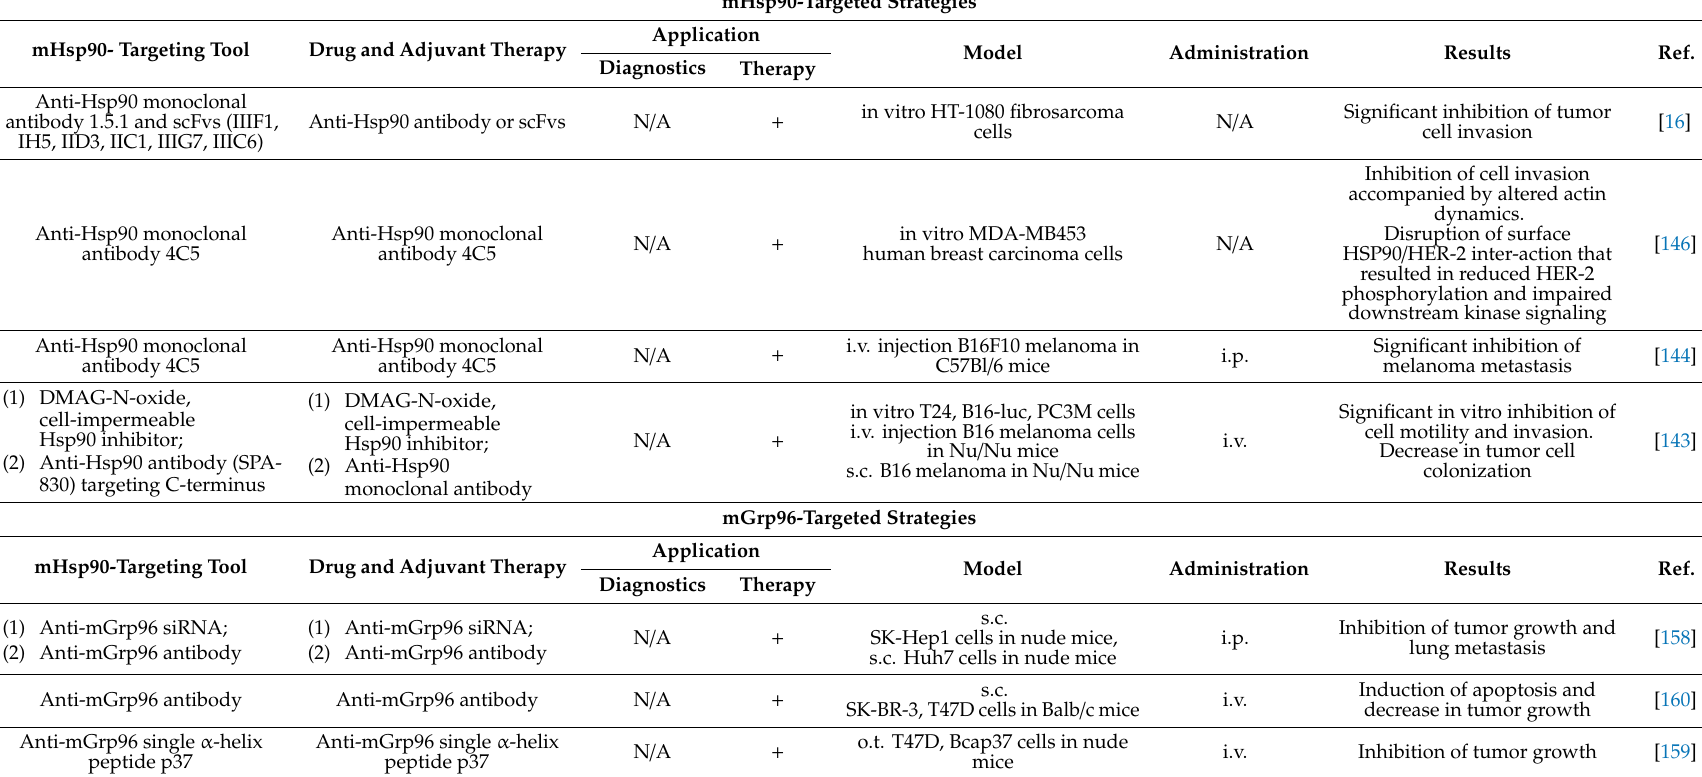
Table 2. Application of the membrane-associated Hsp90 and GRP96 for tumor